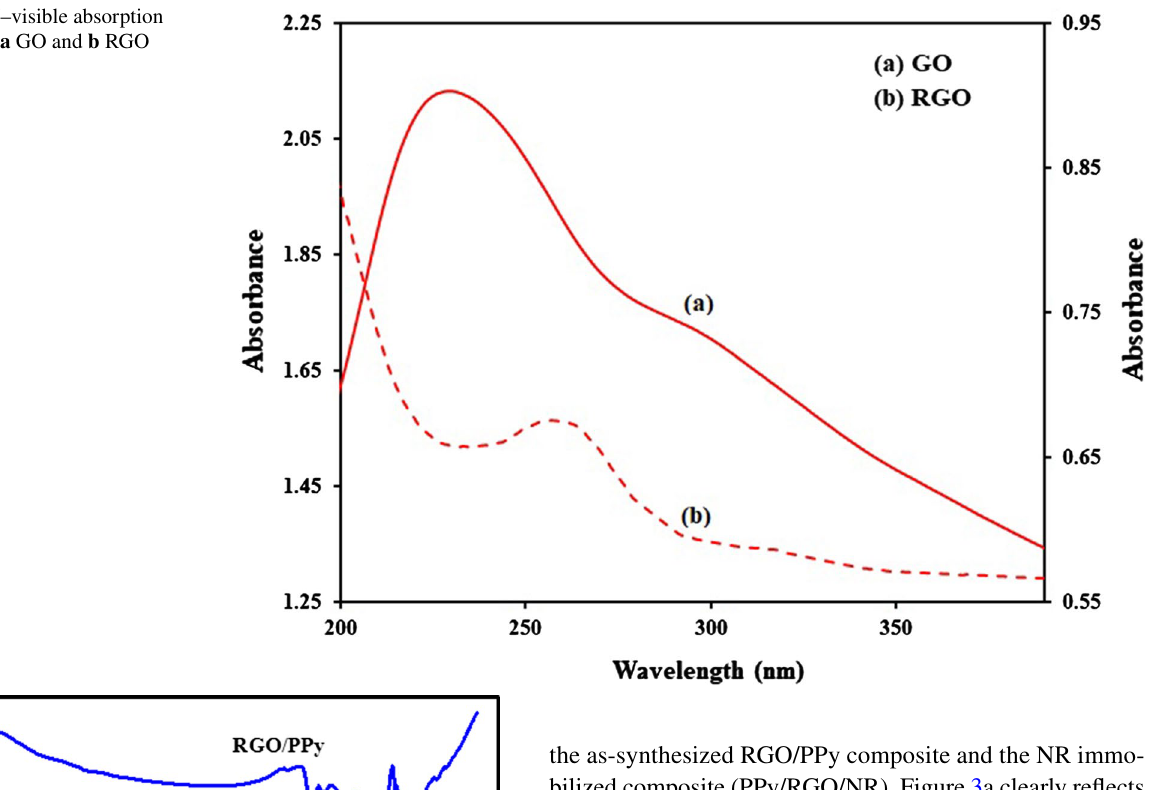
Fig. 1 UV–visible absorption spectra of a GO and b RGO